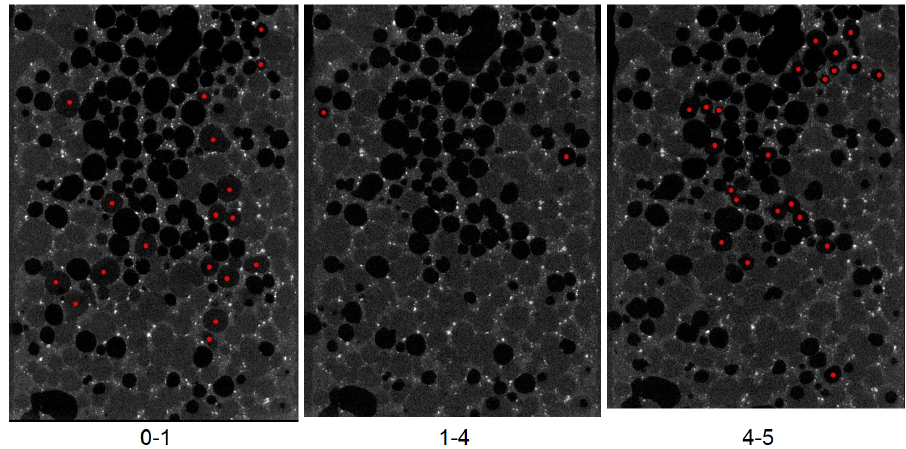
Figure 5. Cross section images of the time-lapse in-situ investigation. Pores that filled with water between the load steps are indicated with red